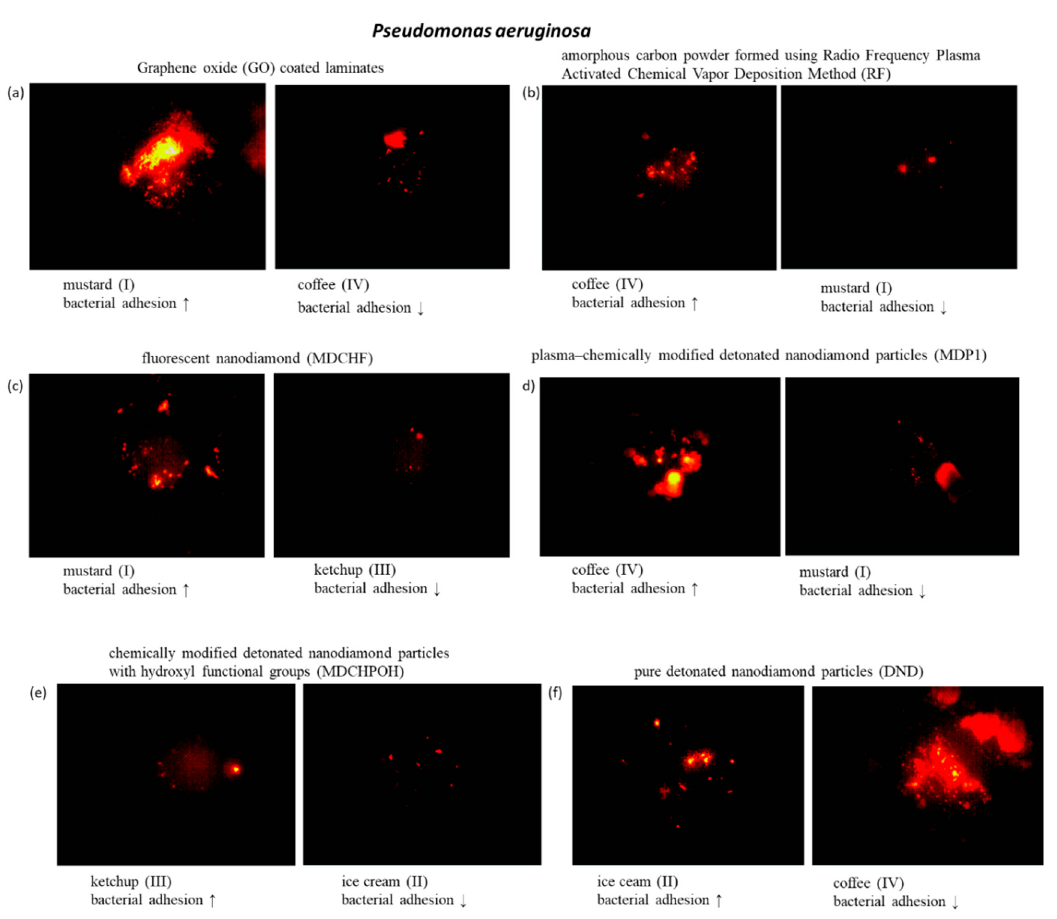
Figure 15. Images of Pseudomonas aeruginosa adhesion to laminates for food films I—mustard, II—ice cream, III—ketchup, IV—coffee, with the lowest and highest adhesion to layers formed by: ( a ) Graphene Oxide (GO) film; ( b ) amorphous carbon powder formed using Radio Frequency Plasma Activated Chemical Vapor Deposition Method (RF); ( c ) fluorescent nanodiamond (MDCHF); ( d ) plasma–chemically modified detonated nanodiamond particles (MDP1); ( e ) chemically modified detonated nanodiamond particles with hydroxyl functional groups (MDCHPOH); ( f ) pure detonated nanodiamond particles